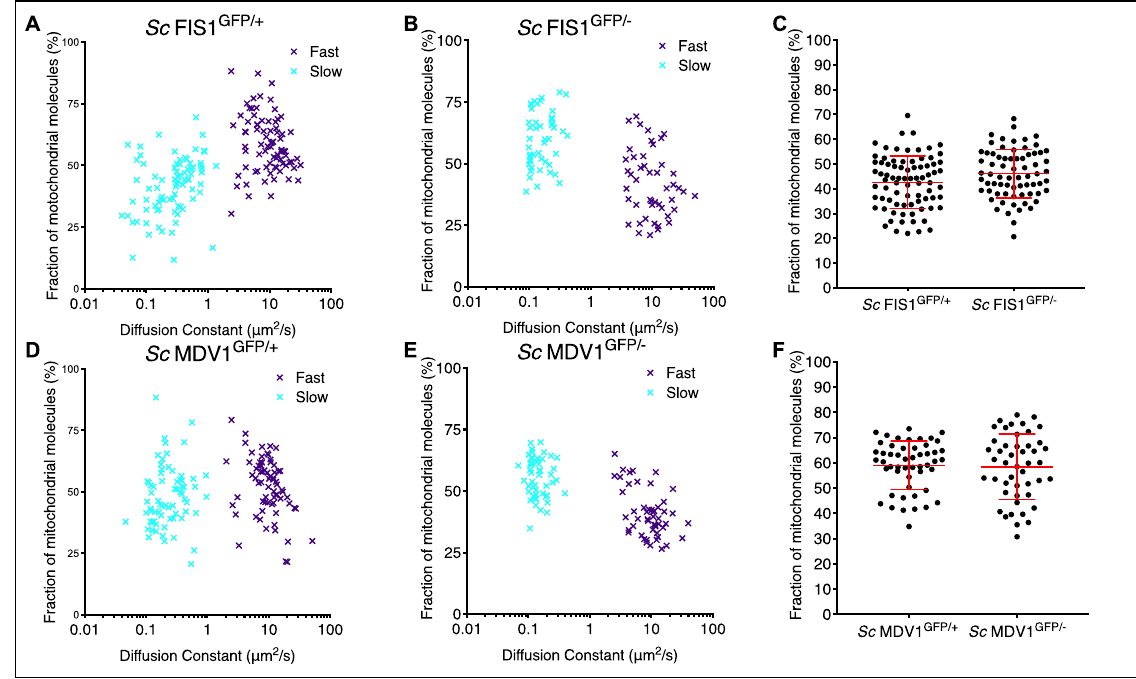
Figure 6. Modelling Fis1p mobility in respiring GFP-labelled living yeast cells by FCS. The FCS data on mitochondrial Fis1p-GFP obtained for single Sc FIS1 GFP/+ ( n = 80), Sc FIS1 GFP/− ( n = 70), Sc MDV1 GFP/+ ( n = 51) and Sc MDV1 GFP/− ( n = 48) cells growing in media containing glycerol were fitted to a two-component model to estimate the numbers of fast-diffusing (purple spots) and slow-dif- fusing (light blue spots) molecules. Shown are 2D plots comparing the diffusion rate to the fraction of mobile molecules measured in the confocal volume for the Sc FIS1 GFP/+ ( A ), Sc FIS1 GFP/− ( B ), Sc MDV1 GFP/+ ( D ) and Sc MDV1 GFP/− ( E ) cells. Scatter plots of the proportion of slow-moving Fis1p-GFP molecules in Sc FIS1 GFP/+ and Sc FIS1 GFP/− cells are shown in panel ( C ) and Sc MDV1 GFP/+ and Sc MDV1 GFP/− cells in panel ( F ). Statistical analysis was performed using the Mann-Whitney two-tailed t -test. Errors bars show mean and SD.